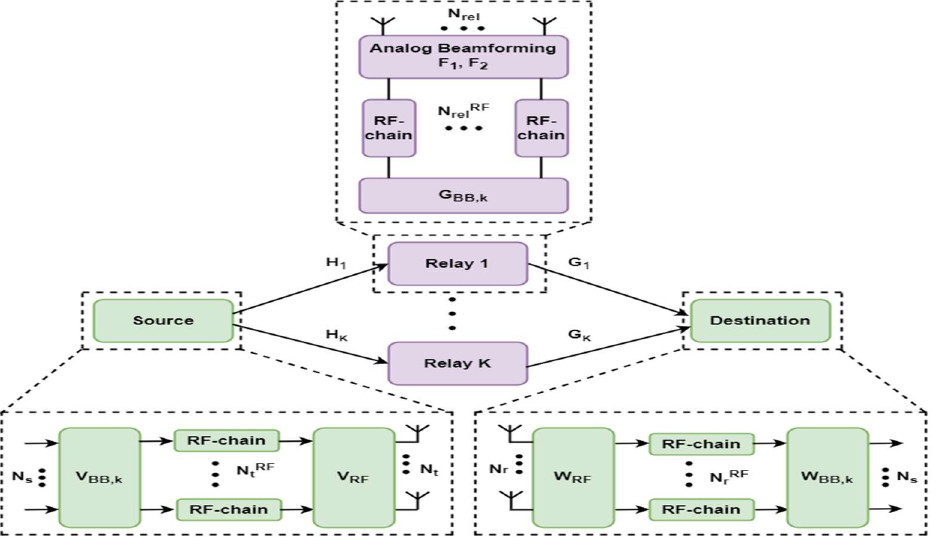
Figure 1. Block diagram of the proposed hybrid beamforming and relay selection for a two-hop multi-relay network.